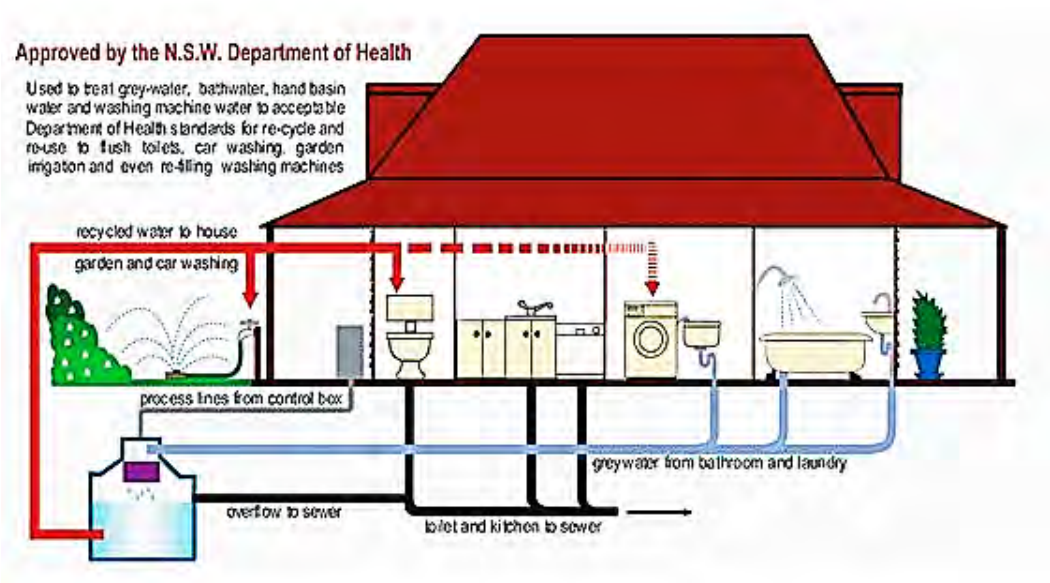
Figure 12. A Simple Grey Water Recycling System